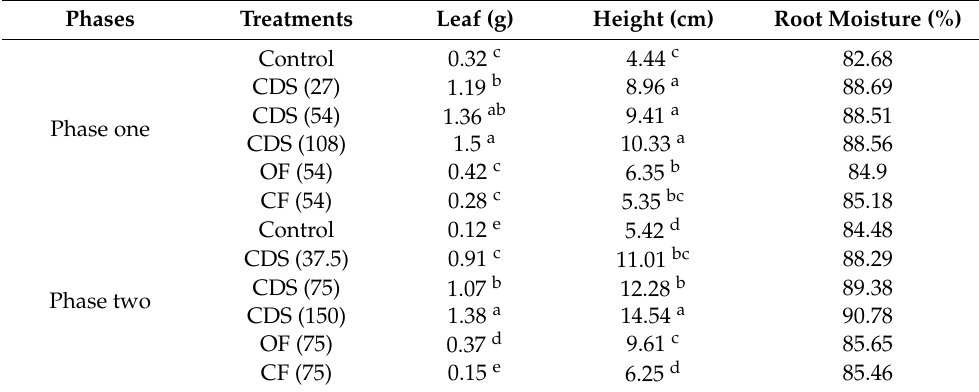
Table 11. Chinese cabbage biomass, height and moisture of the